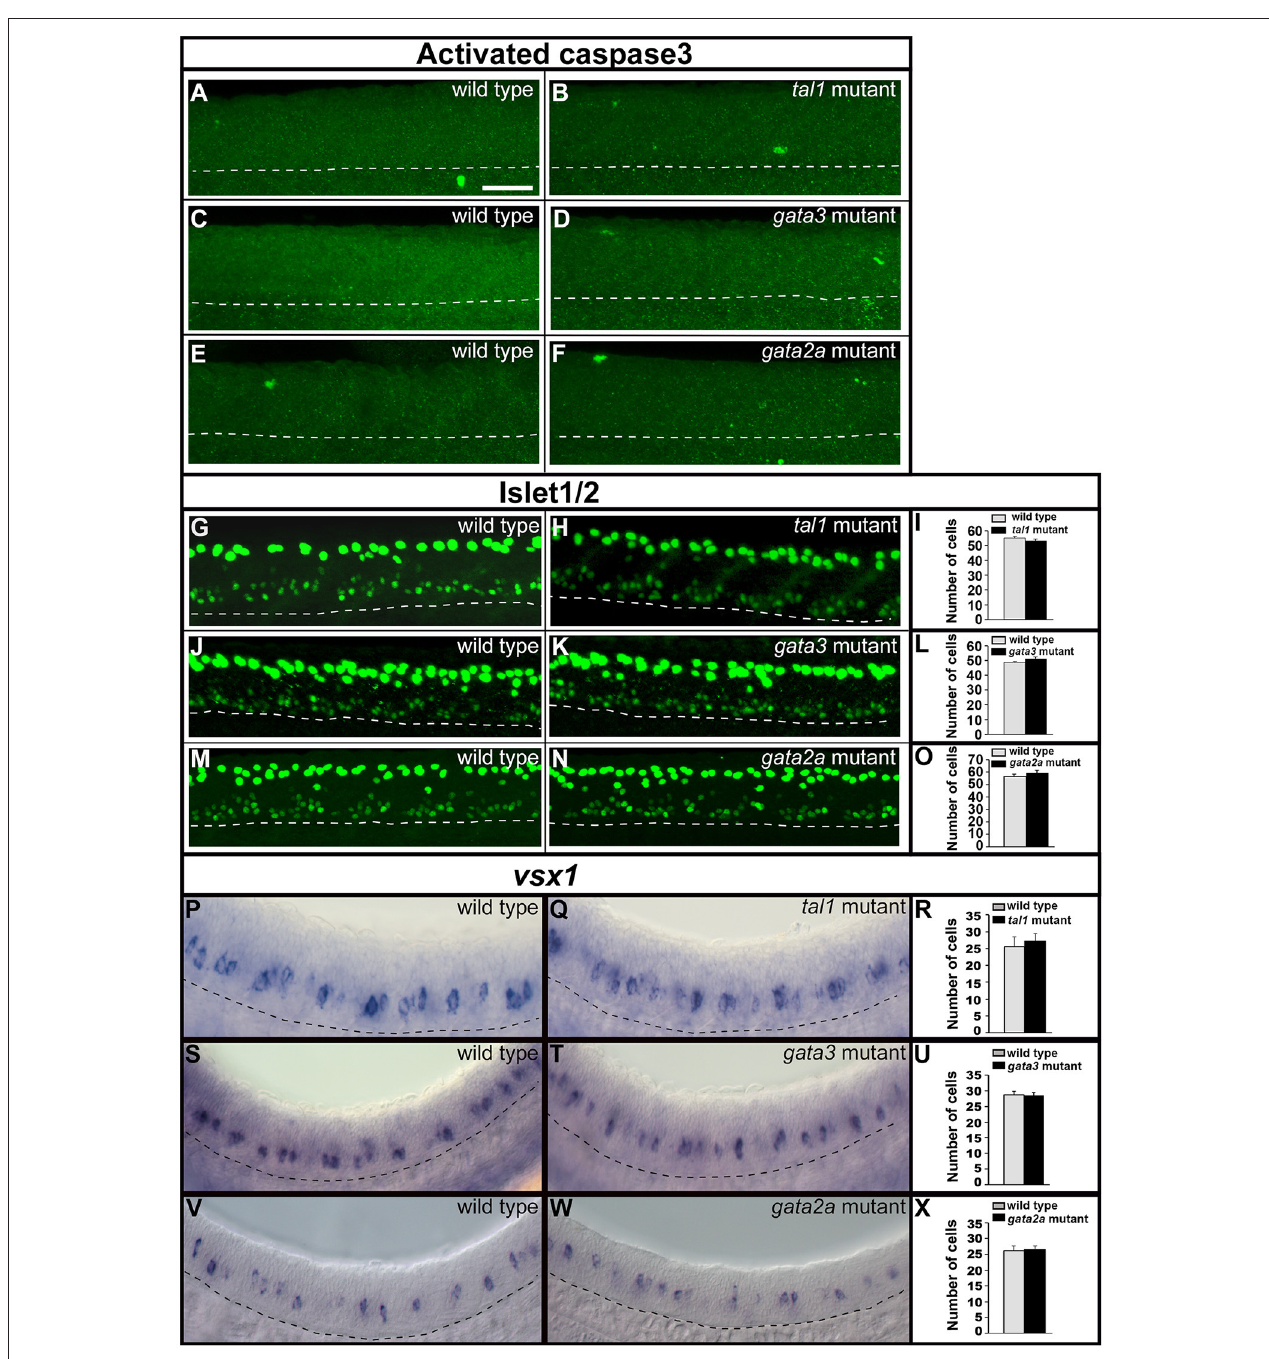
FIGURE 6 | Activated caspase3 and Islet1/2 immunohistochemistry and expression of vsx1 in wild type and mutant embryos. Lateral views of 24h WT sibling and mutant embryos as indicated. Dashed lines mark ventral limit of spinal cord. Dorsal, top; anterior, left. Scale bar = 50 microns. (A–F) Immunohistochemistry for activated Caspase-3. Very few labeled cells are seen in WT or mutant embryos (0–3 cells in a 5 somite-length of spinal cord). (G,H,J,K,M,N) Immunohistochemistry for Islet-1 and Islet-2. The smaller labeled nuclei in the ventral spinal cord correspond to motoneurons. The larger more dorsal nuclei belong to Rohon-Beard cells. Mean numbers of Islet1/2 expressing motoneurons in WT and mutant embryos ( I,L,O ; see Supplementary Table 6 for P- values). Only ventral cells that correspond to motoneurons were counted. These also have smaller nuclei than more dorsally-located Rohon Beard cells. (P,Q,S,T,V,W) vsx1 expression in V2a neurons. Mean numbers of vsx1 -expressing V2a neurons in WT and mutant embryos ( R,U,X , see Supplementary Table 6 for P- values). None of the comparisons contained in this figure revealed statistically significant differences.